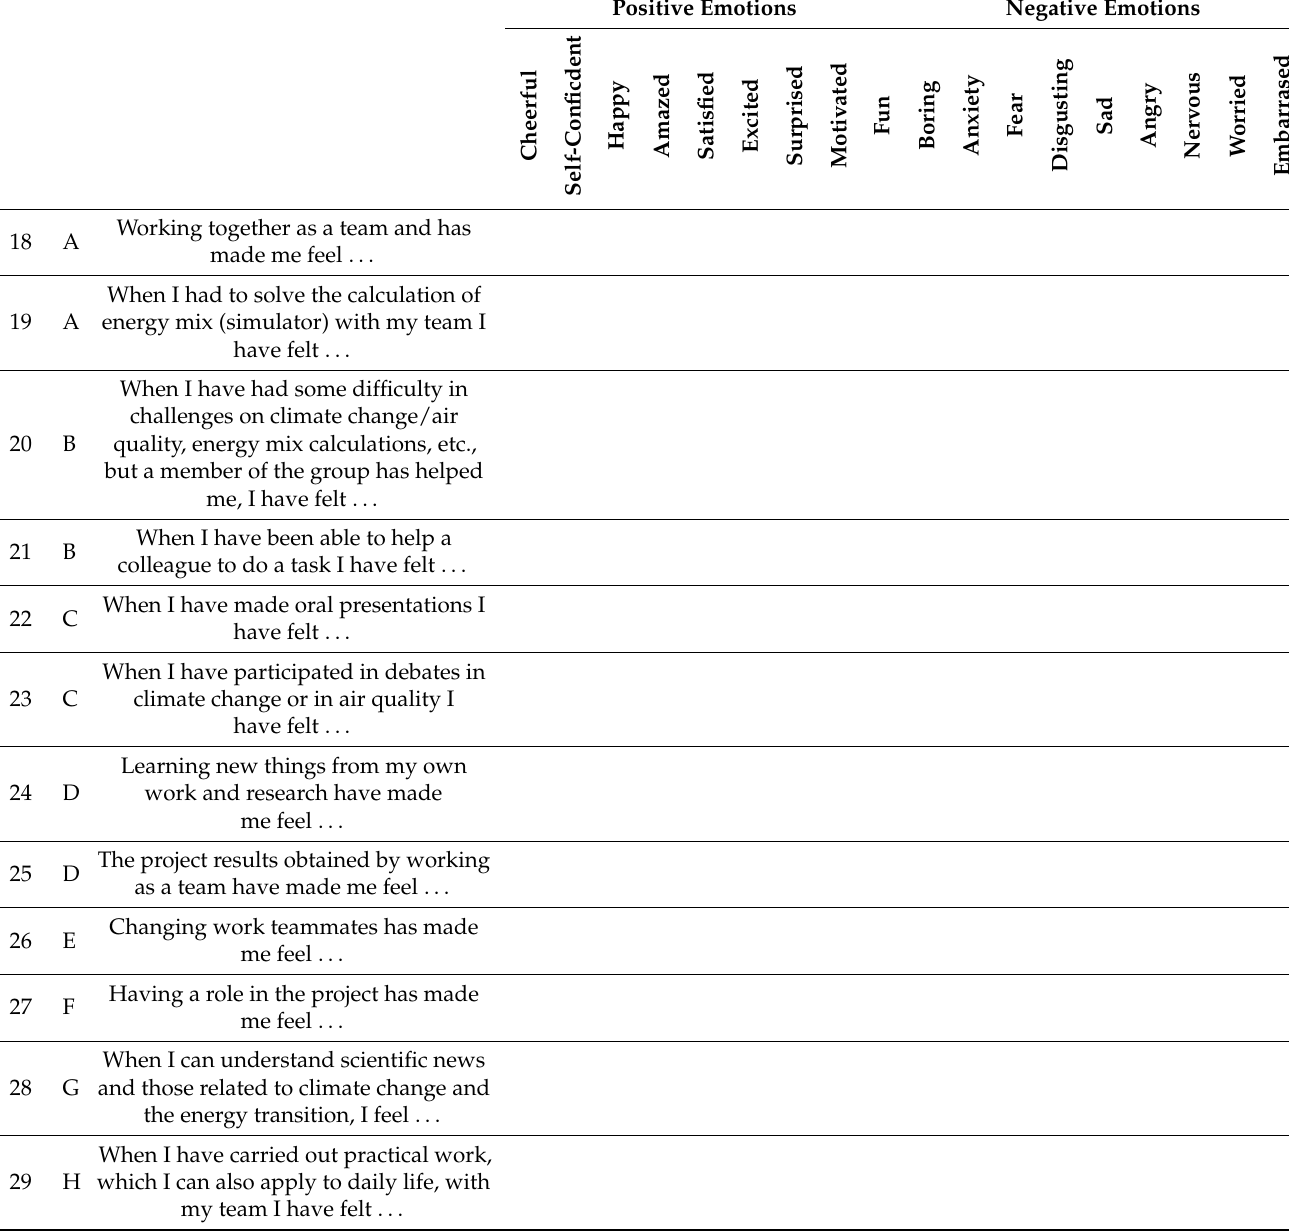
Table A2. Emotions caused during the project based on D á vila et al. (2017) [29], (Block 2). Indicate the emotions that you think best fit EACH SITUATION of those listed below.